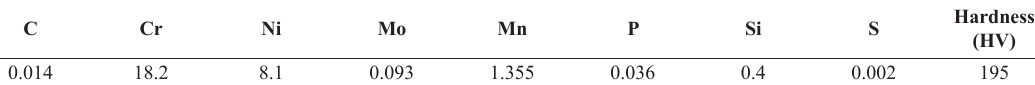
Table 1. Chemical composition (wt-%) and